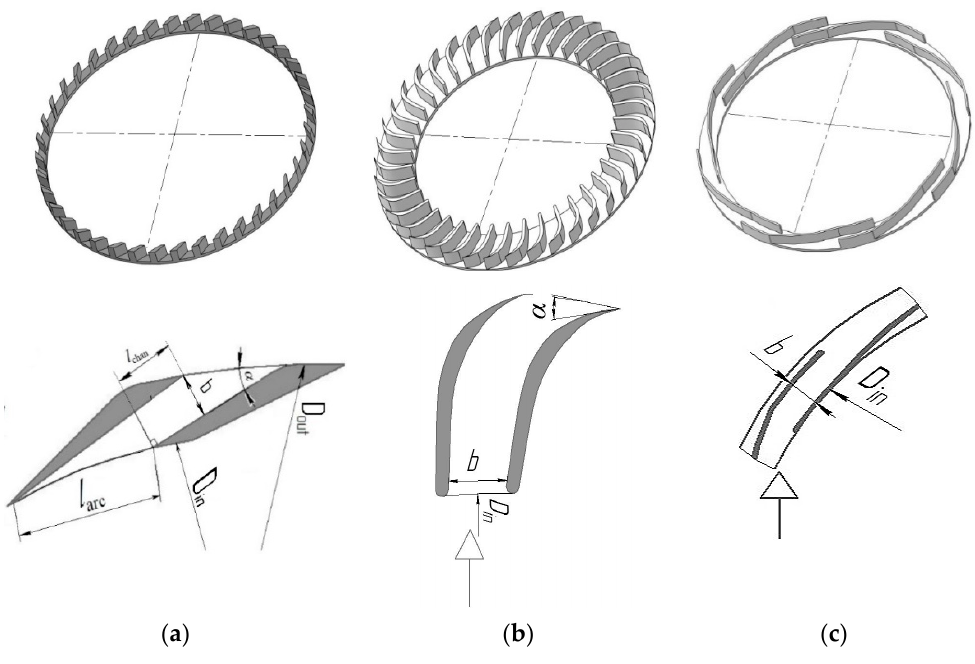
Figure 2. Swirler models with straight ( a ), profiled ( b ), and annular channels ( c ). Table 1. Parameters of the studied swirlers. The swirlers were blown through with air at a temperature of 25 ◦ C, with the orifice- measured air consumption being up to 100 m 3